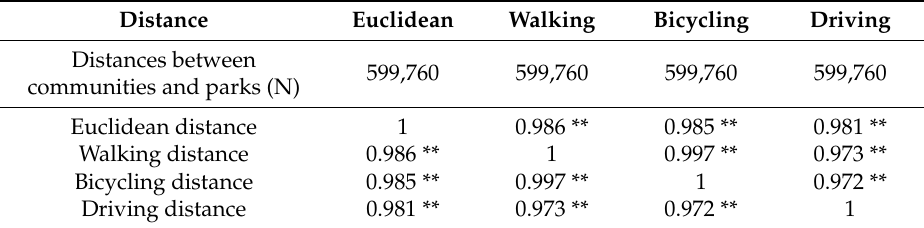
Table 3. Global Pearson correlations between alternative types of distance. Distance Euclidean Walking Bicycling Driving Distances between communities and parks (N)